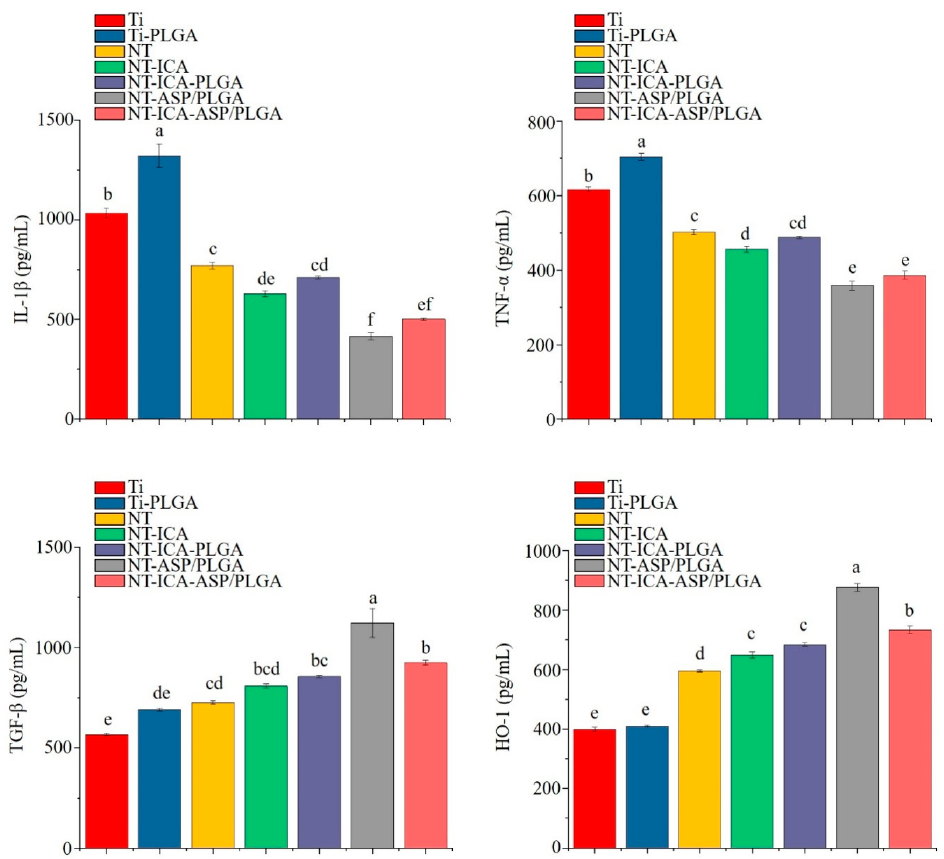
Figure 8. ELISA results representing the RAW 264.7 cytokine secretion on different substrates after 3 days of culture. Different lowercase letters indicate statistically significant differences between different groups ( p < 0.05). Data are mean ± SD, n = 3 replicates each group.